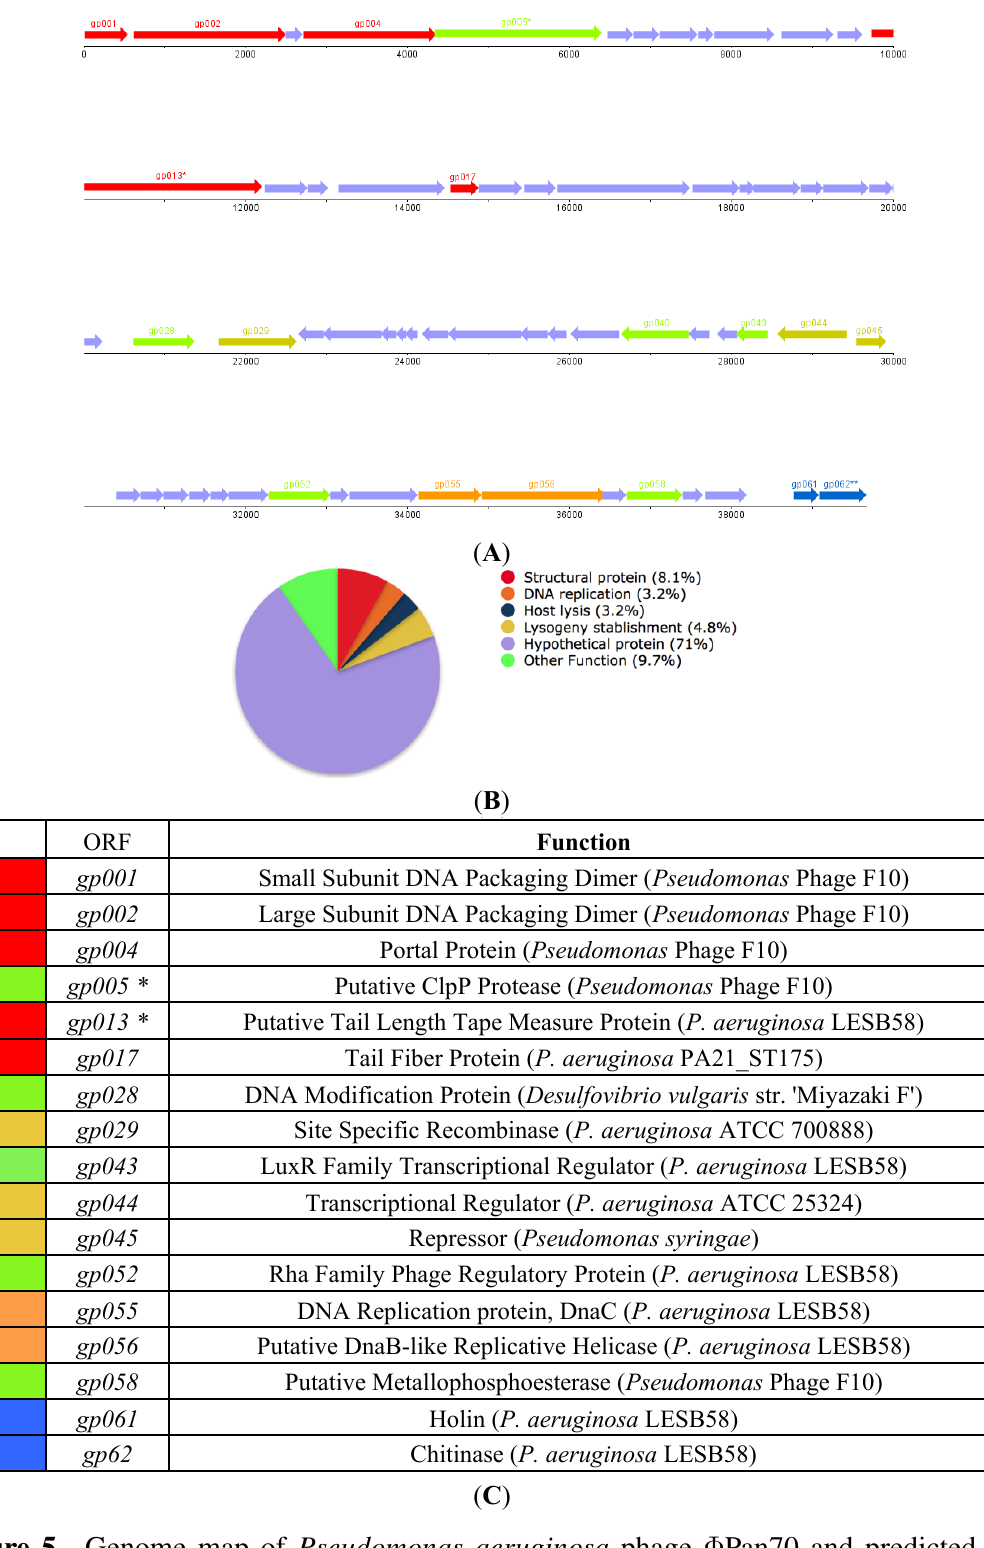
Figure 5. Genome map of Pseudomonas aeruginosa phage Φ Pan70 and predicted gene functions. Bacteriophage Φ Pan70 genome map ( A ); functions distribution pie chart ( B ); and protein functions predicted ( C ). In ( A , C ),* denotes disrupted ORF, potentially due to sequencing errors associated to the presence of homopolymeric segments. The pie chart in ( B ) shows the percentage of ORFs assigned to each functional group; “other functions” group contains predicted proteins unrelated to phage proteins. Coverage and e -values for predictions in ( C ) are shown in the Supplementary Material Table